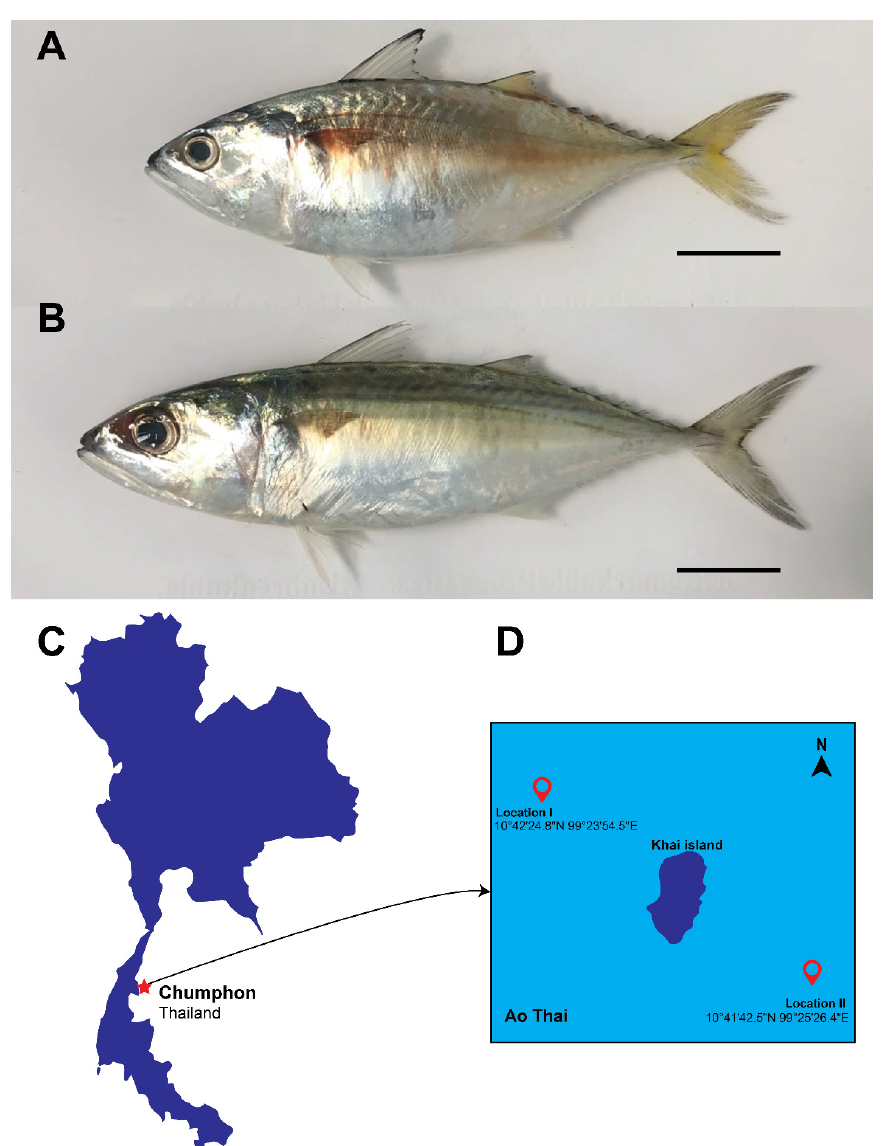
Figure 1. Images of R. brachysoma ( A ) and R. kanagurta ( B ) from Ao Thai, Chumphon Province, Thailand. Scale bars represent 3 cm. ( C ) Chumphon Province (red star). ( D ) Sampling site location.